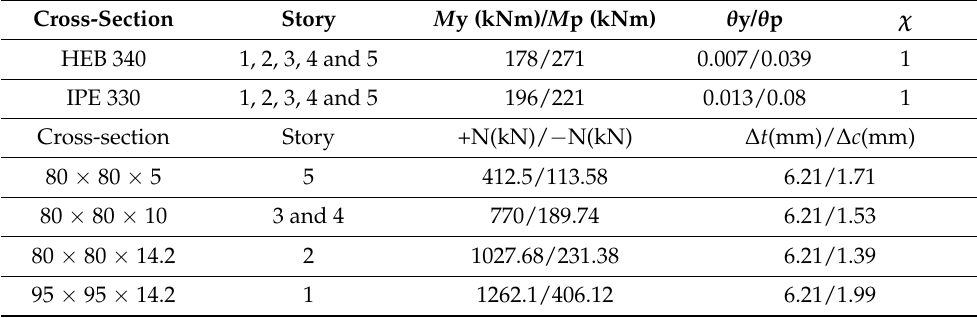
Table 4. Braced frame plastic hinge